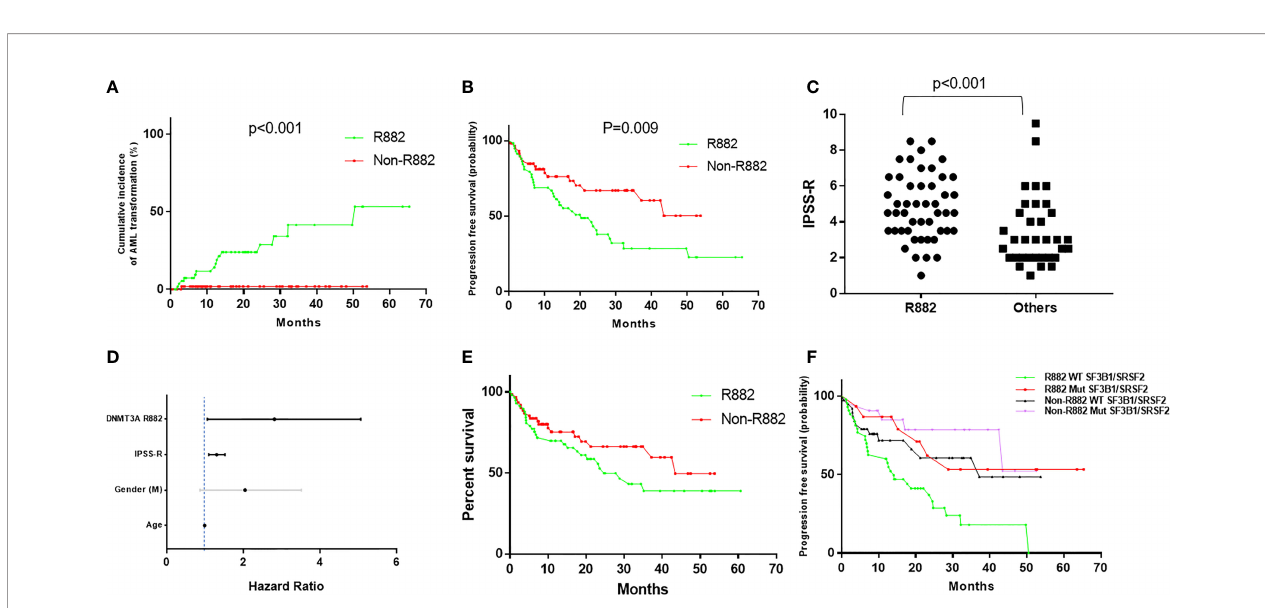
FIGURE 4 | DNMT3A R882 mutations confer increased risk of AML transformation and worse progression free survival in MDS, which are masked by the coexisting SF3B1 or SRSF2 mutations. (A) Cumulative incidence of AML transformation in DNMT3A (R882 vs. Non-R882) mutant MDS. (B) Progression free survival analysis in patients with DNMT3A (R882 vs. Non-R882) mutant myelodysplastic syndrome (MDS). (C) The distribution of IPSS-R scores in the R882 group and the other group. (D) Cox proportional hazards model analysis of risk factors for worse progression free survival. Statistically signi fi cant factors are highlighted with black lines. (E) Overall survival analysis in patients with DNMT3A (R882 vs. Non-R882) mutant myelodysplastic syndrome (MDS). (F) Progression free survival analysis in DNMT3A (R882 vs. Non-R882) mutant MDS with mutant and wildtype SF3B1/SRSF2 .